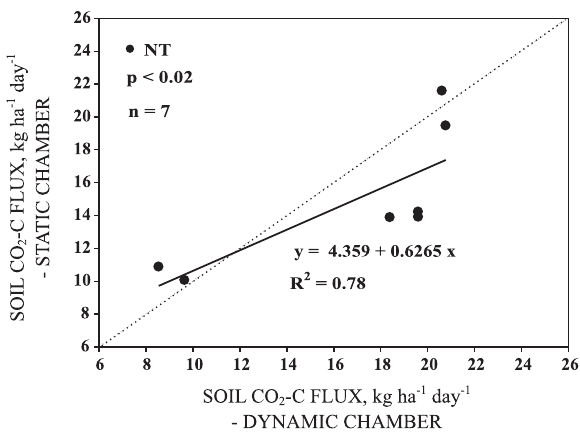
-C flux measured 2